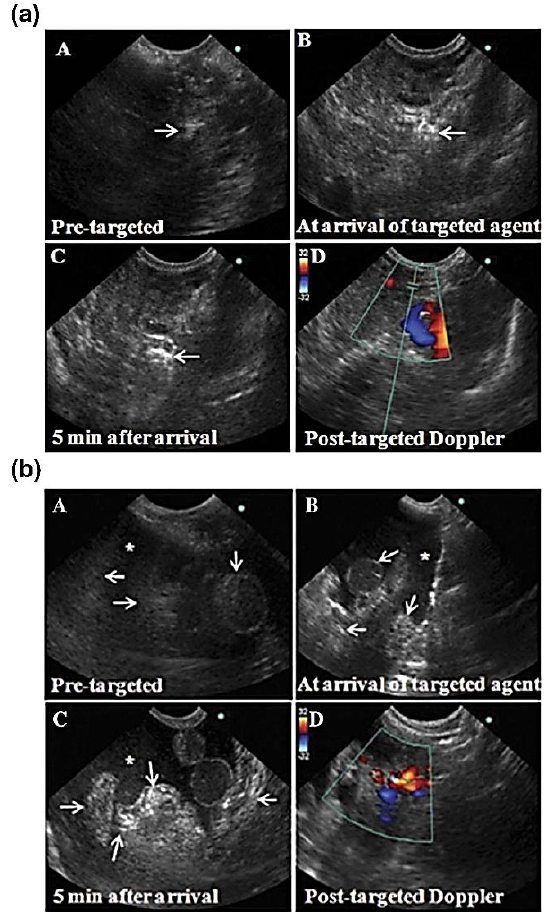
Figure 5. Targeted ultrasound microbubbles in spontaneous ovarian cancer egg-laying hen model by Barua et al. demonstrating the efficacy of relatively simple ultrasound molecular imaging agents in a native ovarian cancer model [114]. Commercially available microbubbles were functionalized with an affinity ligand, death receptor 6 (DR6), and subsequently intravenously administered and imaged at the across multiple time points, with peak intensity generated 5 min after the arrival of microbubbles to the site. The microbubbles significantly increased ultrasound imaging intensities measured via transvaginal ultrasound across early stage ovarian cancer ( a ), where the tumor was limited to the ovary, as well as late-stage disease ( b ). Imaging compared prior to the arrival of the microbubbles ( A ), post arrival ( B , C ) and a Doppler scan post-arrival of the microbubbles ( D ). Arrows indicate tumor seeding; * indicates profuse ascites.